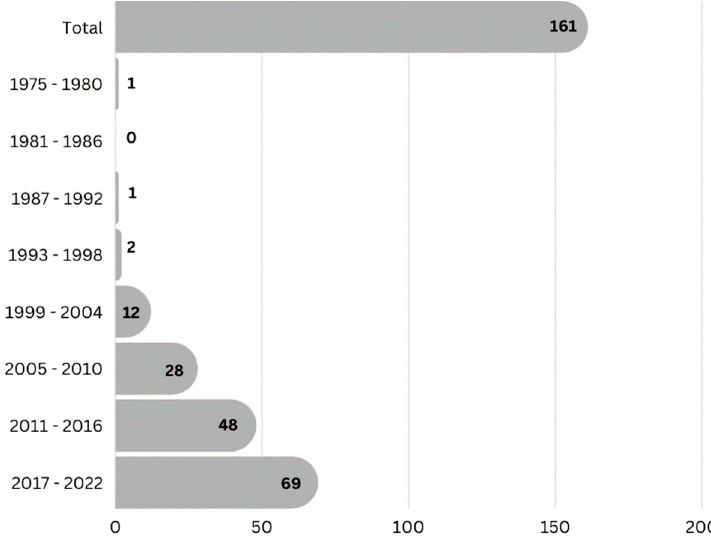
Figure 3. Retrieved articles related to phytochemistry and pharmacological studies of medicinal plants used by the Tenggeresse people. Papers were collected from a previous report (1975–2022) of the same plants studied across the globe for similar pharmacological claims (Google Scholar, PubMed, and SciFinder Scholar).